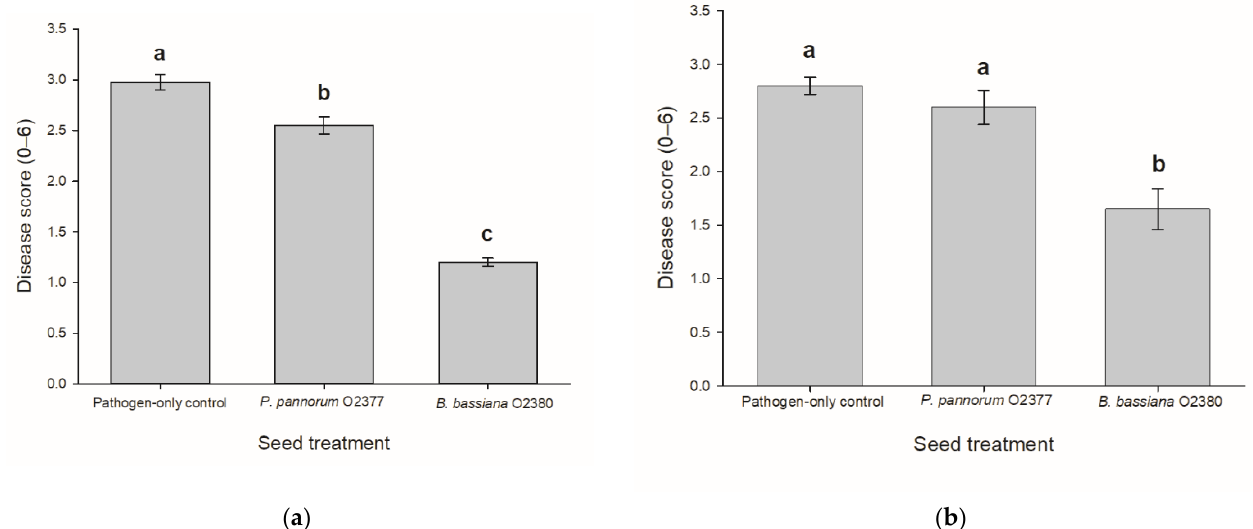
Figure 4. Mean disease score of oilseed rape ( Br. napus ), cv. Flash leaves after wounding and inoculation by Leptosphaeria maculans following treatment of seeds by Pseudogymnoascus pannorum O2377, Beauveria bassiana O2380 or an aqueous Tween-20 ® solution (pathogen-only control) ( ± SE). Results are presented from two replicate experiments, Experiment 1 ( a ) and Experiment 2 ( b ). Bars followed by the same letter are not significantly different ( p < 0.05). Disease scores were assessed using a 0–6 scale whereby 0 = no symptoms on wound site; 1 = lesions on the wound site <1.5 mm; 2 = lesions on the wound site 1.5–3.5 mm; 3 = lesions on the wound site >3.0 mm; 4 = grey-to-green tissue collapse 3.1–5.0 mm; 5 = grey-to-green tissue collapse >5.0 mm ( ≤ 10 pycnidia); 6 = grey-to-green tissue collapse >5.0 mm (>10 pycnidia).